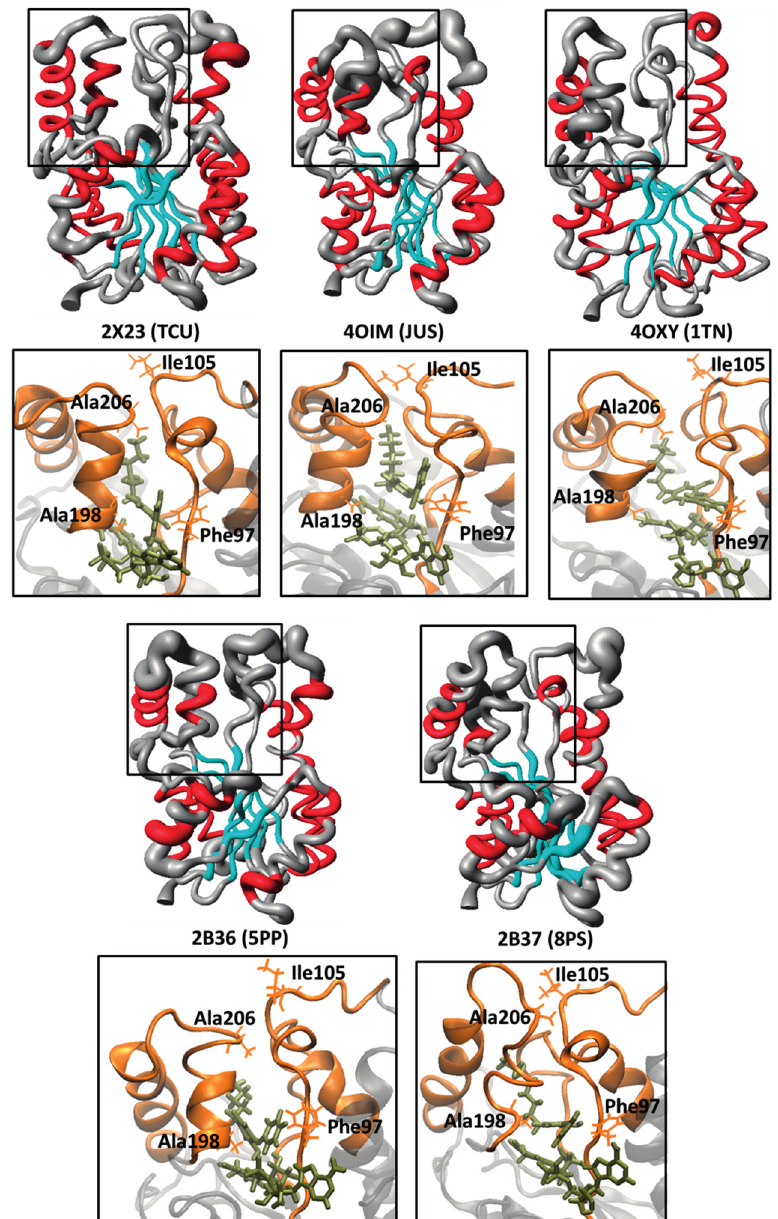
Figure 6. Spatial RMSD (RMSF) of InhA-NADH (protein secondary structure color code: α -helix, red; β -sheet, cyan; loop, grey) in complex with the alkyl diphenyl ethers inhibitors (TCU, JUS, 1TN, 5PP, and 8PS) during the MD simulations and the corresponding close view of the substrate binding pocket, showing the Phe97 (LLP-4), Ala198 (AH-6), Ile105 (MLP-4), and Ala206 (LP-6) residues used for measure the LLP-4/AH-6 and MLP-4/LP-6 distances to characterize the protein open and closed